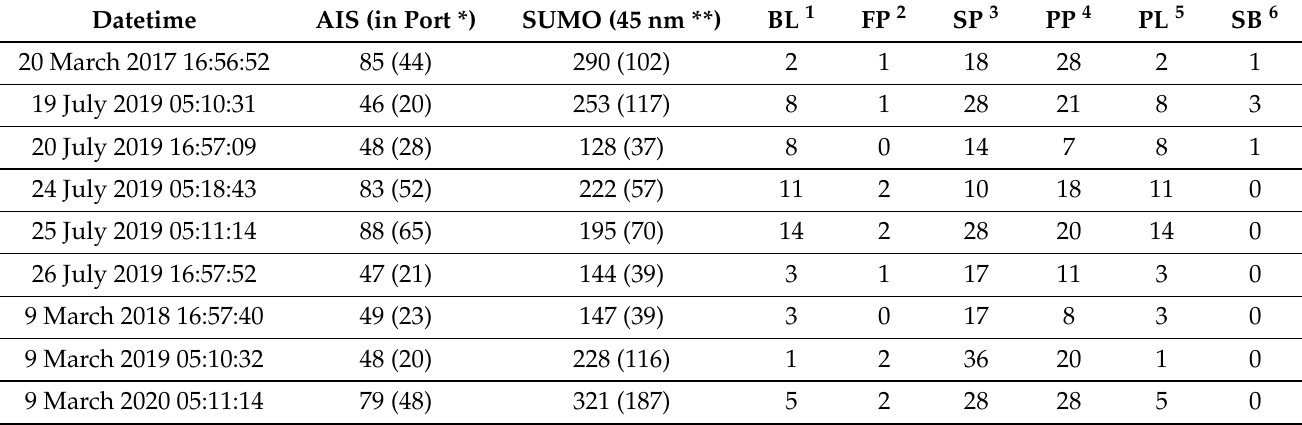
Table 1. Summary of target detection and correlation results for all the processed